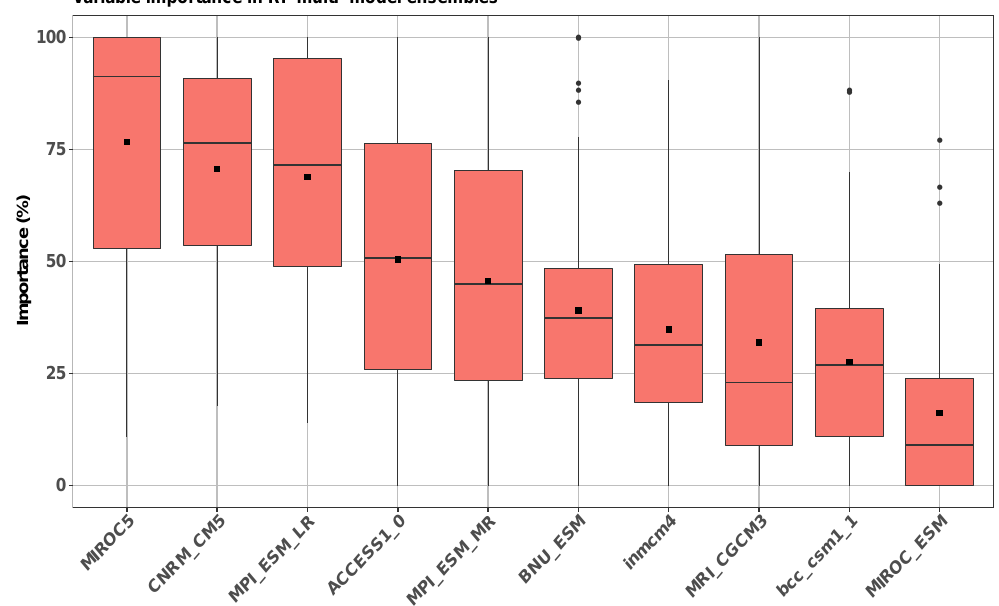
Figure 5. Ranking of relative Random Forest variable importance of MMEs. The importance is scaled (0 to 100) to compare between MMEs and improve their